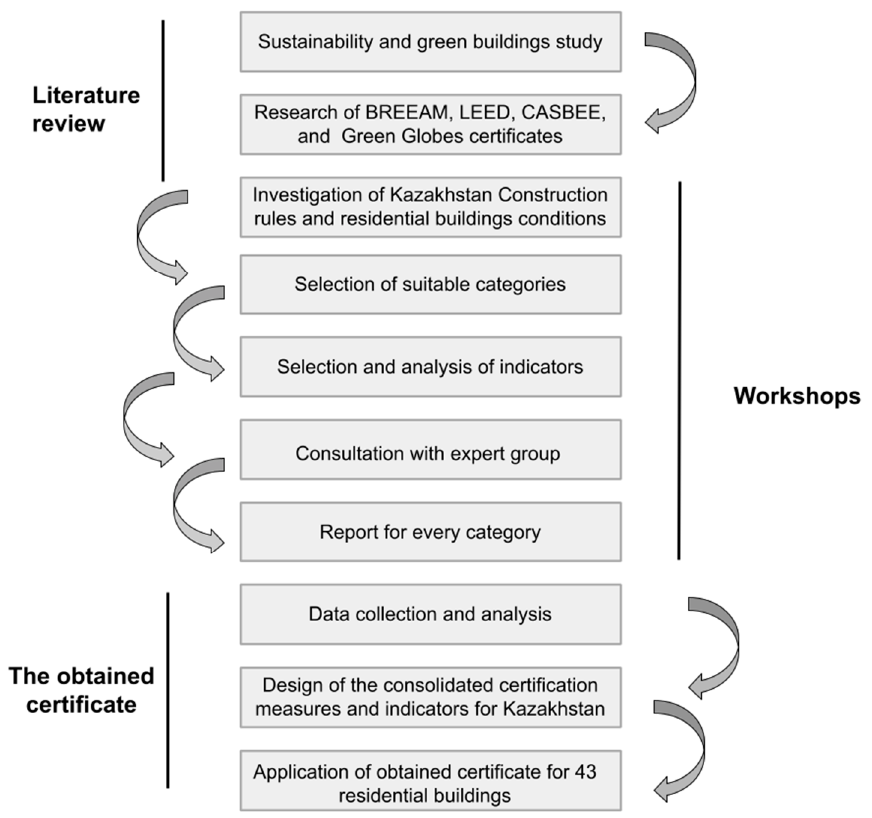
Figure 1. Organization of the methodology.